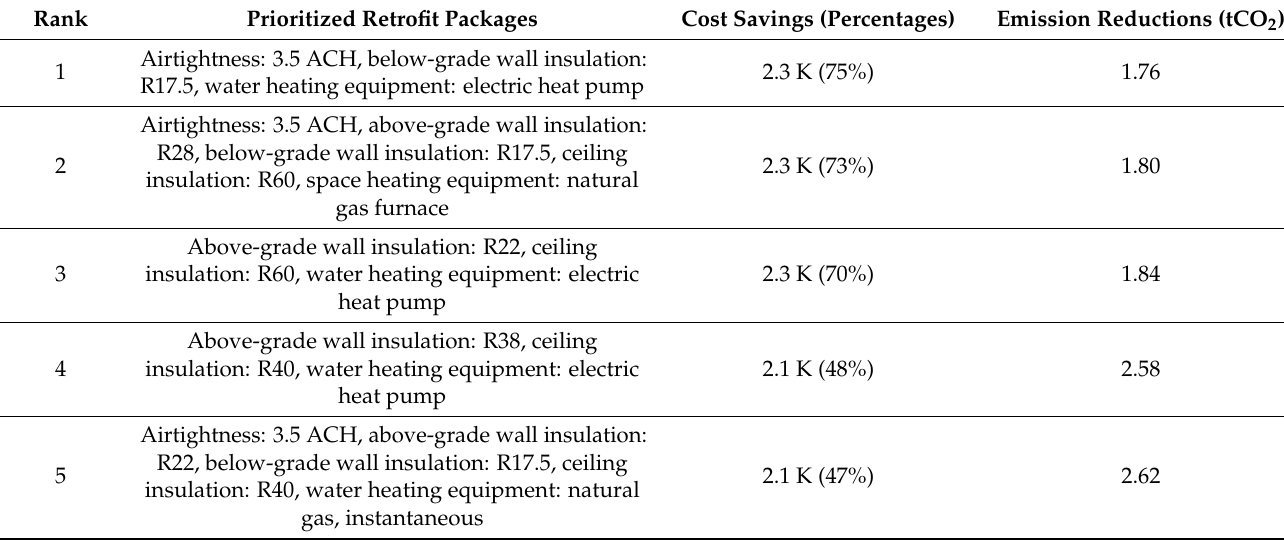
Figure 8. Prioritized retrofit packages on the Pareto-front set. Table 4. Prioritized retrofit